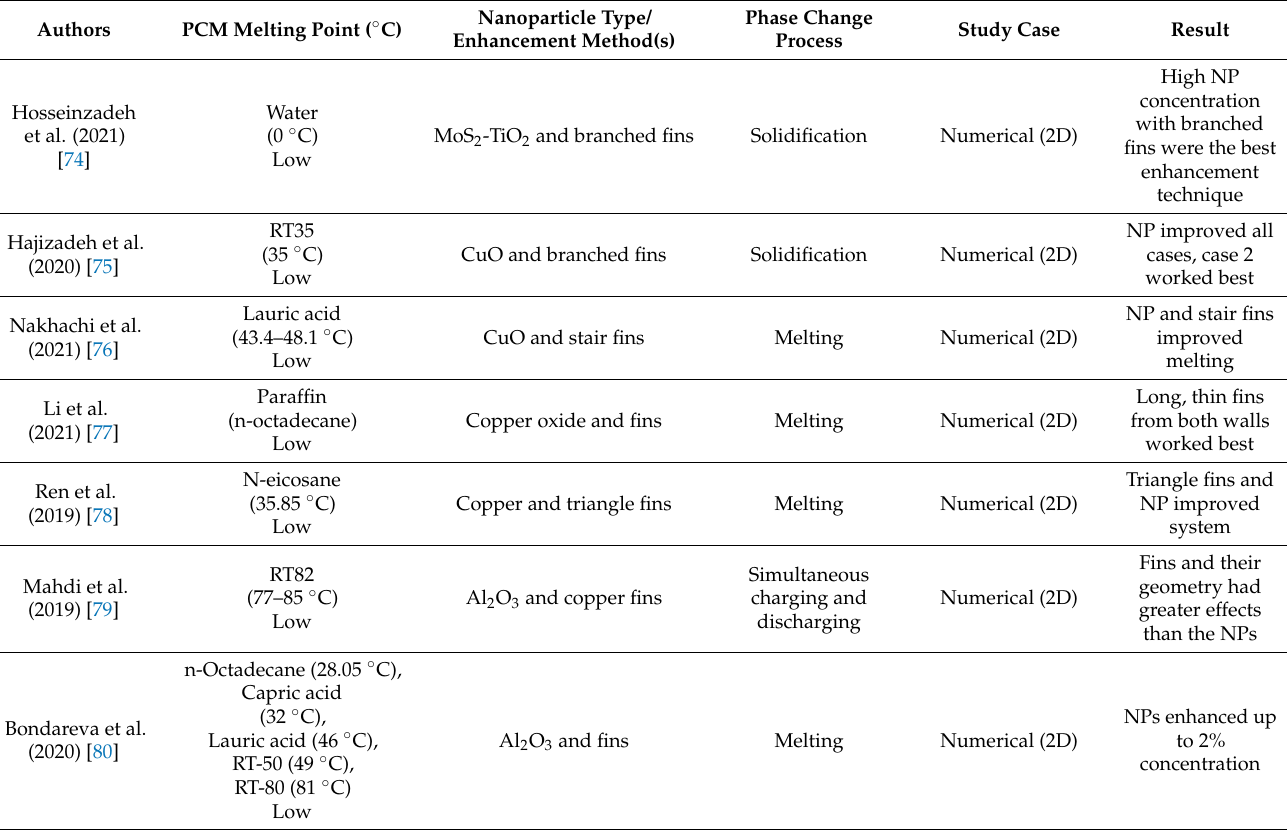
Table 2. A summary of studies that used NePCM combined with fins to enhance LHTES